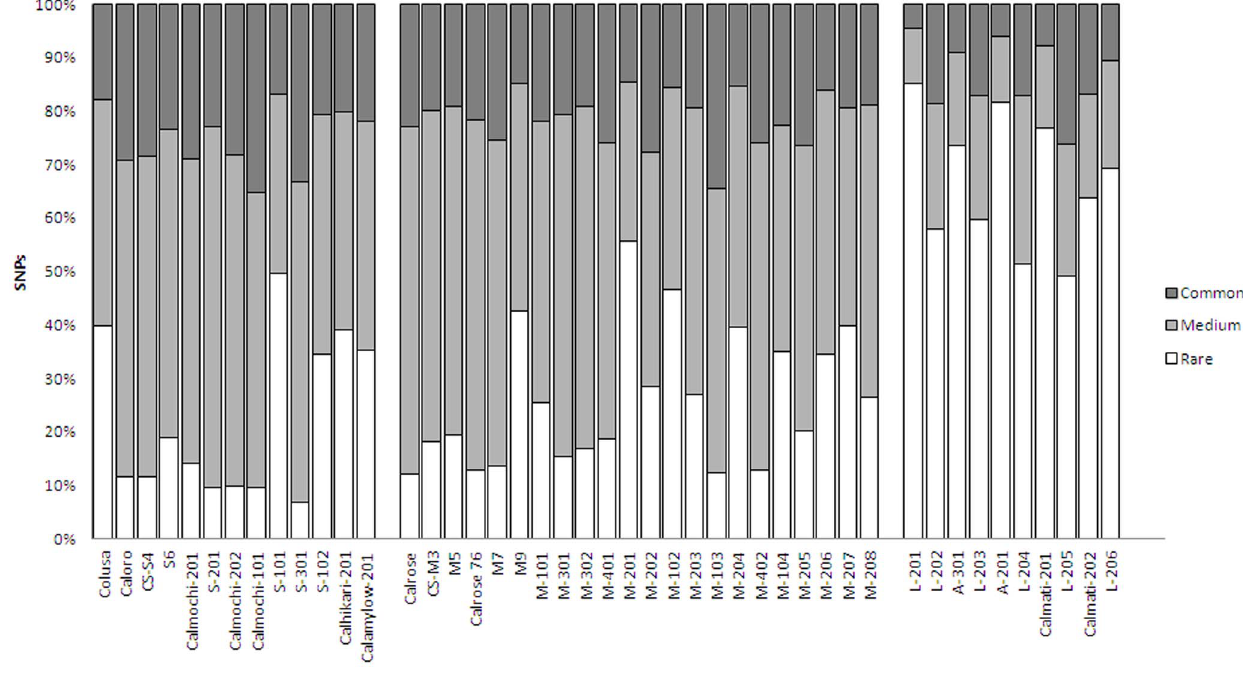
Figure 2. Composition of SNP types in California cultivars. SNPs were grouped into three categories: rare SNPs found in less than 15 cultivars, medium frequency SNPs found in between 16–30 cultivars and common SNPs found in more than 30 cultivars.